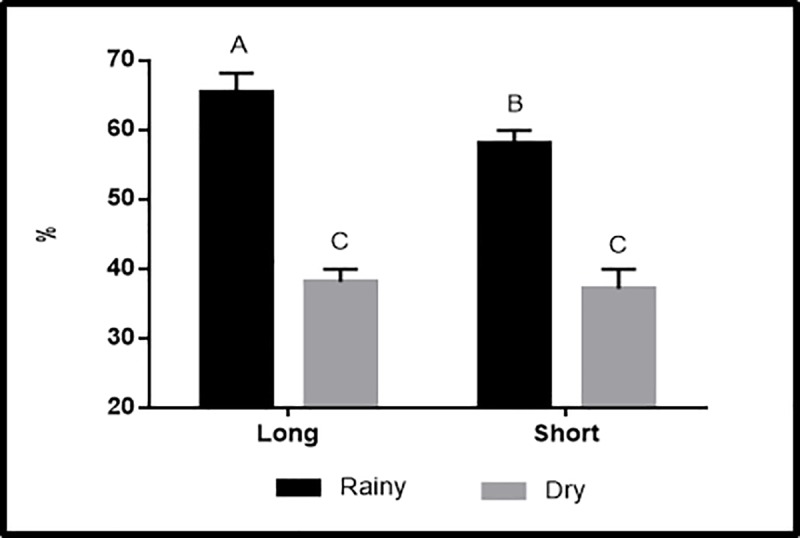
Effect of the interaction between season and distance on load relative humidity (%).AValues with the same capital letters do not differ by Tukey’s test (P > 0.05).